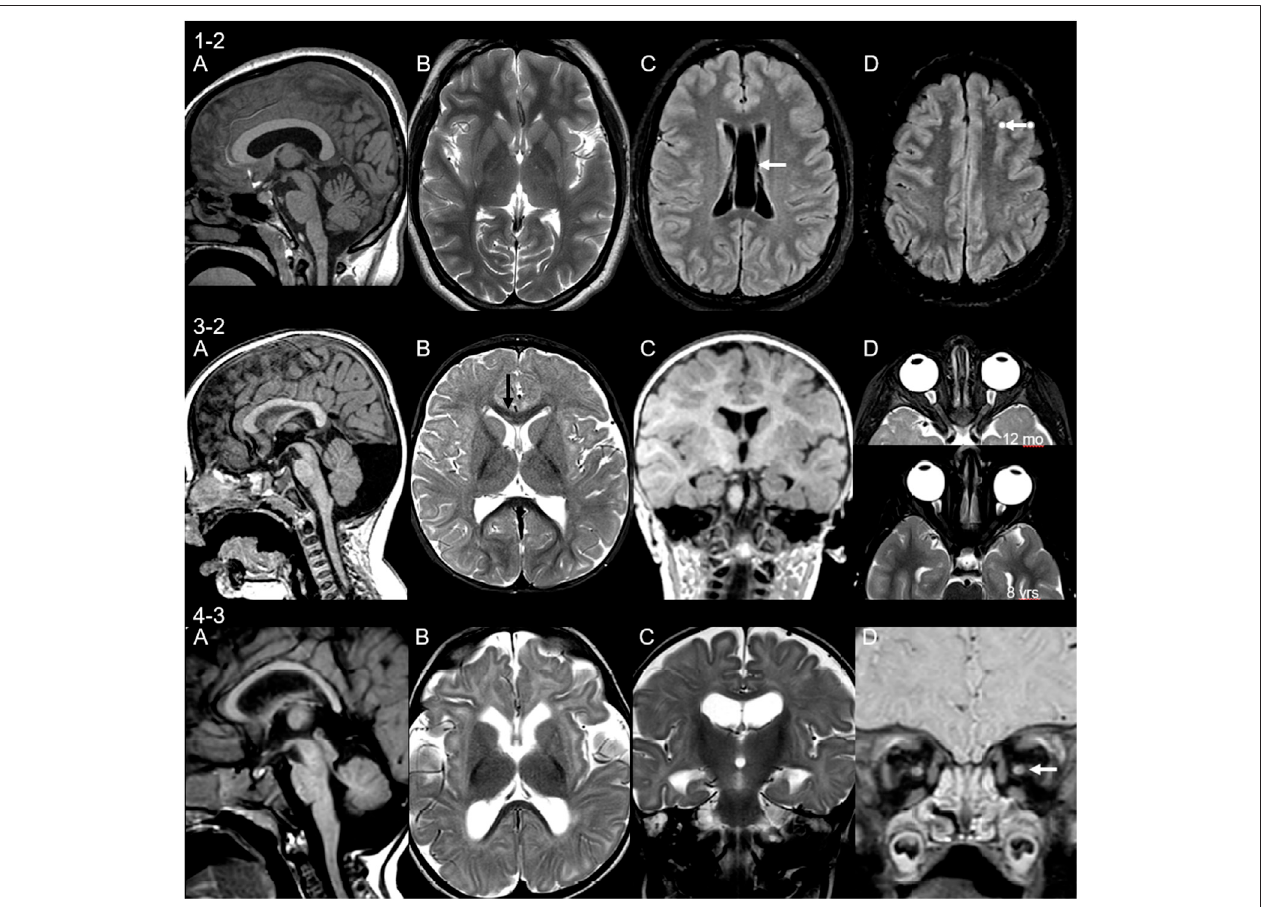
FIGURE5| Neuroimaging fi ndingsinthreeunrelatedpatients. MRIofpatient1-2 atage15 yearsshows (A) thickcorpuscallosumandmildcerebellarhypoplasia, (B) smallbasalganglia, (C) cavumseptumpellucidumetvergae(arrow),and (D) non-speci fi cpunctatewhitematterlesionson fl uid-attenuatedinversionrecovery(FLAIR) sequences (arrow). Patient 3-2 scanned at 12 months of age shows (A) retrocerebellar cyst and thin cervical cord, (B) signal change of the genu of corpus callosum (immature myelin, black arrow) and small lentiform nucleus, (C) malrotation of hippocampi, and (D) asymmetry of the globes, more prominent on follow-up (lower image). Patient 4-3 at 7 months of age shows (A) small cerebellum and pons and drooping splenium, (B) microcephaly with volume loss of the white matter, delayed myelination, and volume loss of the lentiform nucleus, (C) malrotation of hippocampi, and (D) volume loss of the optic